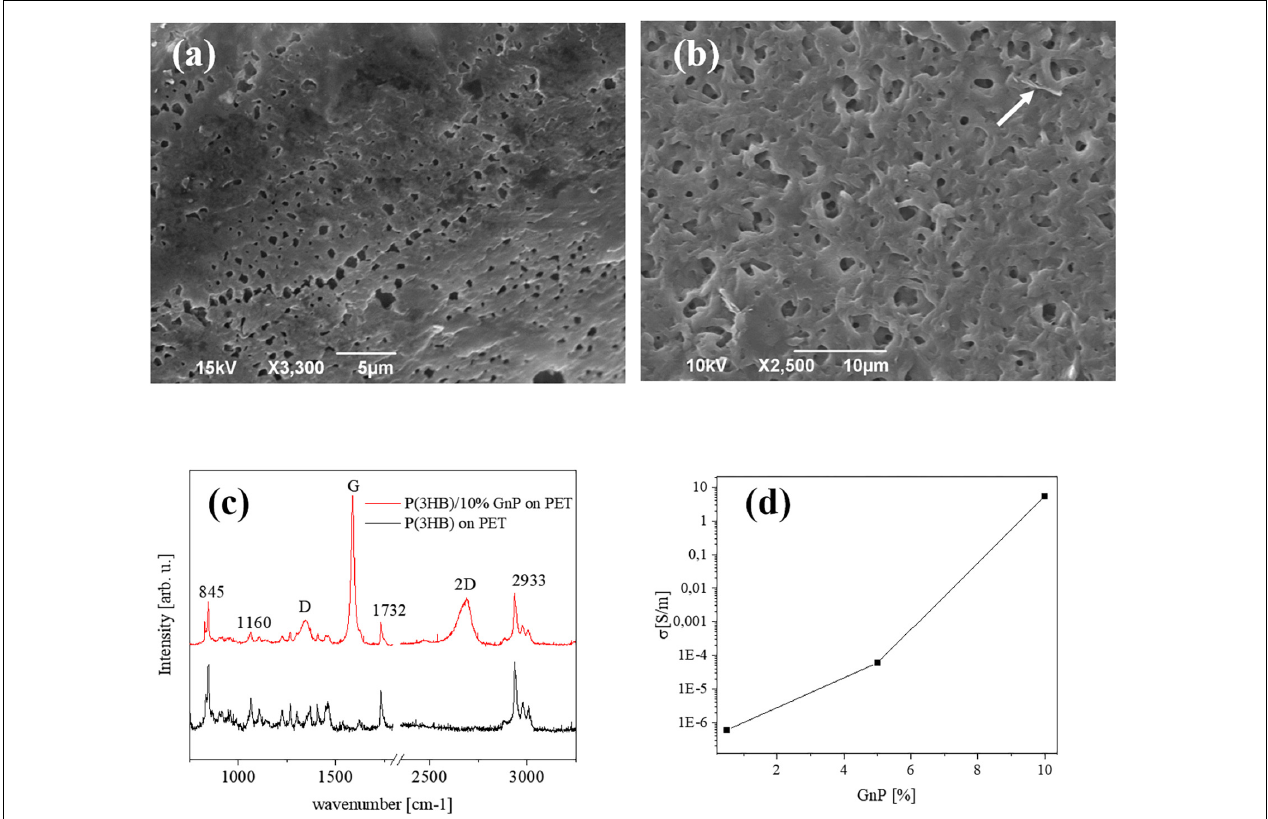
FIGURE 1 | Typical SEM images of the surface of (a) pure P(3HB) films and (b) P(3HB) film containing 10 wt% GnP. (c) µ Raman spectra of P(3HB) and composites (d) electrical conductivity of the composite islands deposited on PET, versus the GnP